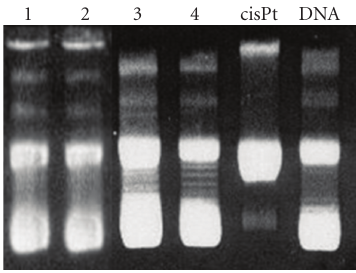
Figure 7: Agarose gel electrophoretic mobility of DNA pBR322 treated with compounds 1 (lane 1); compound 2 (lane 2); compound 3 (lane 3); compound 4 (lane 4); cisplatin (lane 5) and DNA pBR322 (lane 6).